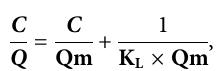
Frontiers in Environmental Science |